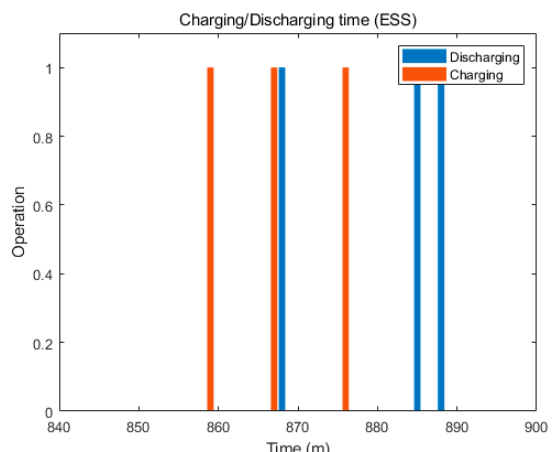
( b ) Figure A2. Load consumption of heating, ventilation, and air conditioning (HVAC) and lighting (LTG) data: ( a ) 14 August 2017 (summer); ( b ) 25 January 2017 (winter). Appendix B. Example of ESS Operation In order to avoid simultaneous charging and discharging in one minute, constraints are additionally complemented as shown in Equations (A1)–(A3). 2 (A3) m denotes a minute and u indicates a decision variable of charging/discharging at each minute. As expressed in Equation (A1), at every hour and minute, charging and discharging action cannot occur